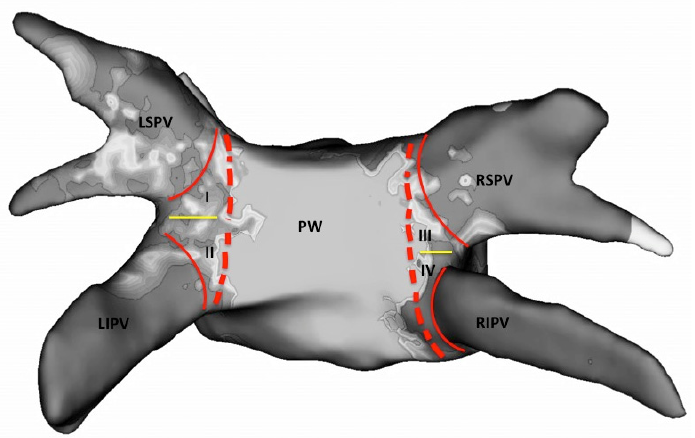
Figure 2. 3D map in a posterior–anterior view (PA) with identification of PV ostia and antral area of the pulmonary veins. Red lines mark the PV ostia. Red dotted lines mark the antral area of the PVs (I = antrum LSPV; II = antrum LIPV; III = antrum RSPV; IV = antrum RIPV). Yellow lines mark the carina between the pulmonary veins. RSPV, right superior pulmonary vein; RIPV, right inferior pulmonary vein; LSPV, left superior pulmonary vein; LIPV, left inferior pulmonary vein; PW, posterior wall.